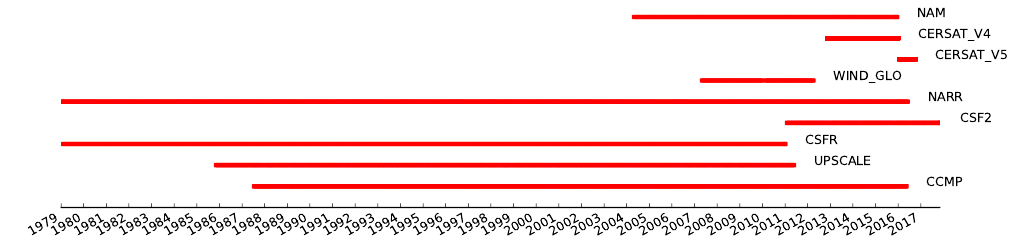
Figure 4. Sources of wind climatology data and temporal